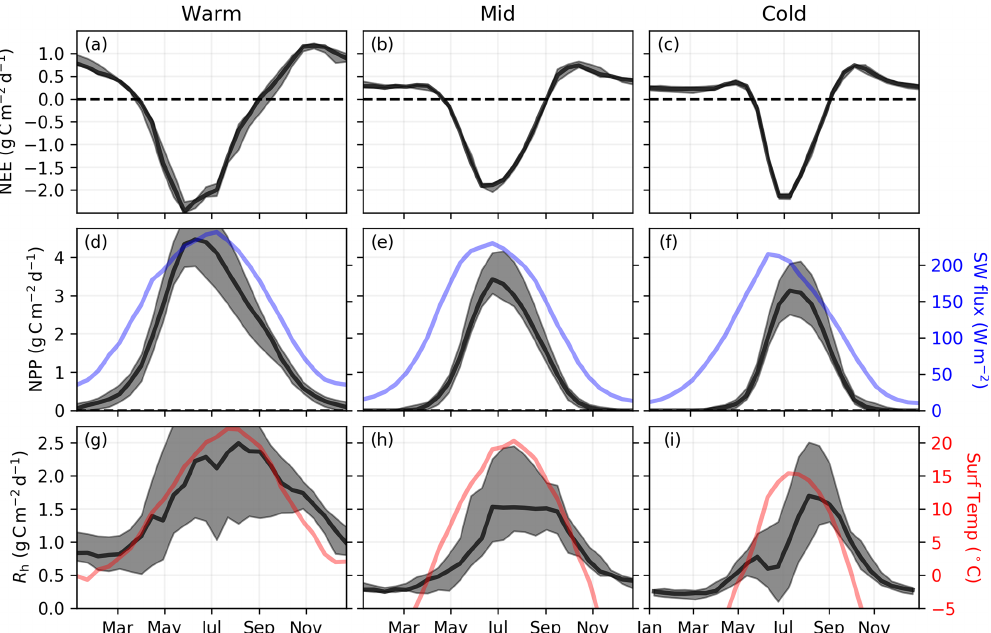
Figure 4. Data-driven 4-year-mean (2015, 2016, 2018, and 2019) 14d NEE, NPP, and R h . (a–c) Mean and ensemble spread of NEE for the CMS-Flux 14d , TM4-4DVar 14d , and CAMS 14d flux inversions. (d–f) Mean and ensemble spread for the data-driven NPP. MERRA-2 Land net downward shortwave flux over land is shown in blue. (g–i) Ensemble estimate of R h = NEE + NPP estimated from the three NEE and NPP estimates. MERRA-2 Land surface temperature is shown in